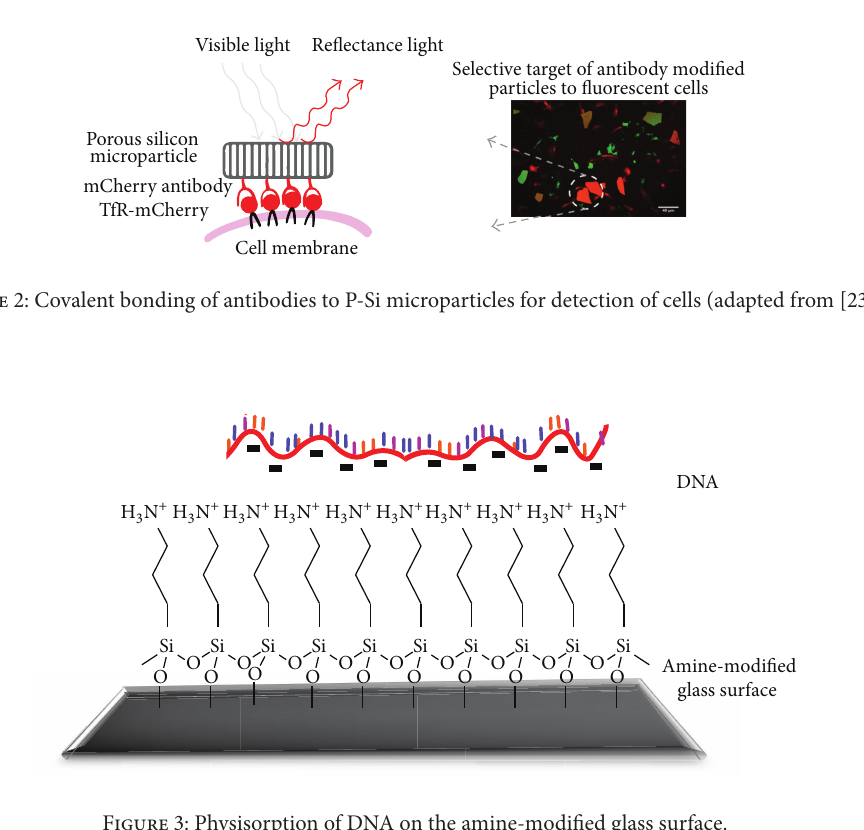
Figure 3: Physisorption of DNA on the amine-modified glass